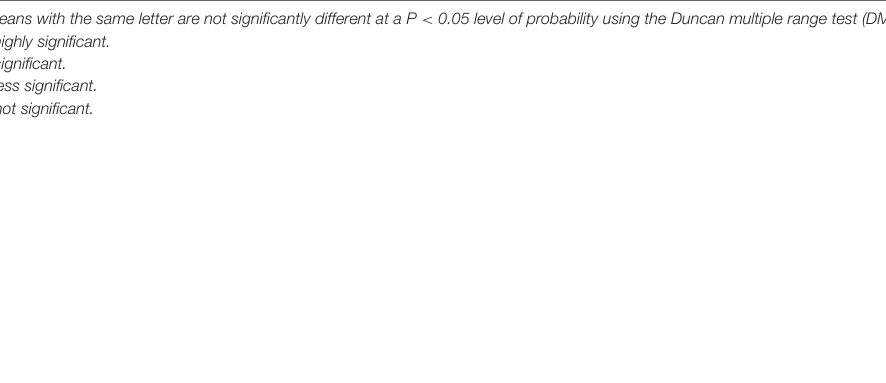
TABLE 9 | Effect of N fertilizer and B. japonicum strains on yield and yield components of Bambara groundnut accessions at harvest in Ibadan and Ikenne in the second season, 2020. Treatment